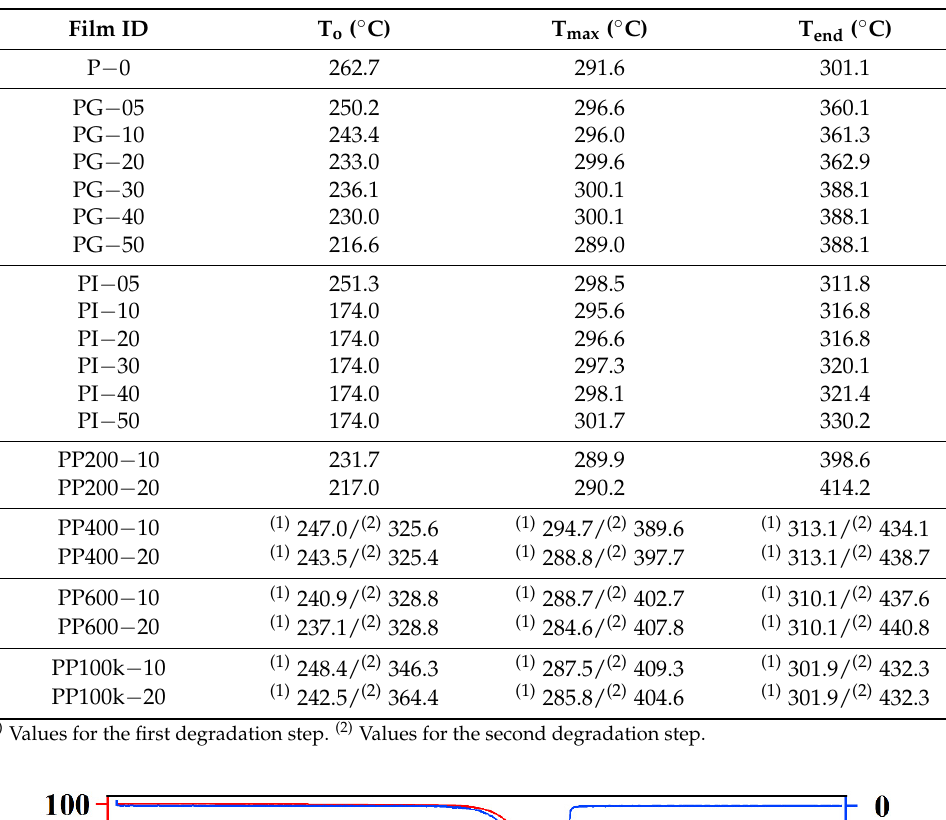
Table 2. TGA parameters of PHBH films.